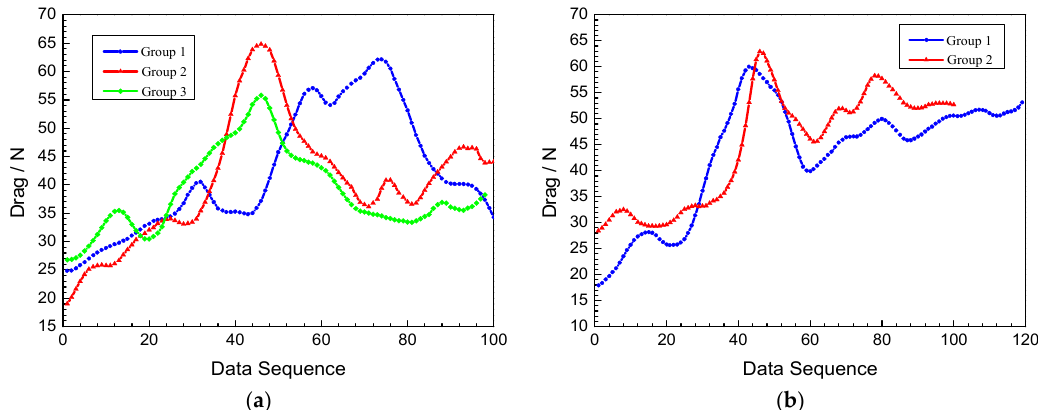
Figure 7. Local drag results of the packer in the horizontal hole with microsteps and cuttings: ( a ) The hole with little cuttings; and ( b ) the hole with lots of cuttings.